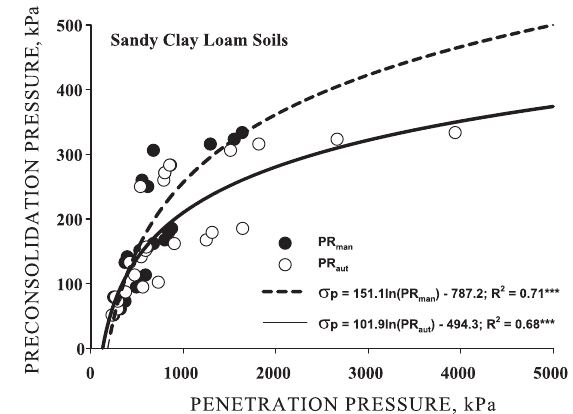
Figure 9. Relation between preconsolidation pressure and penetration resistance for sandy clay loam